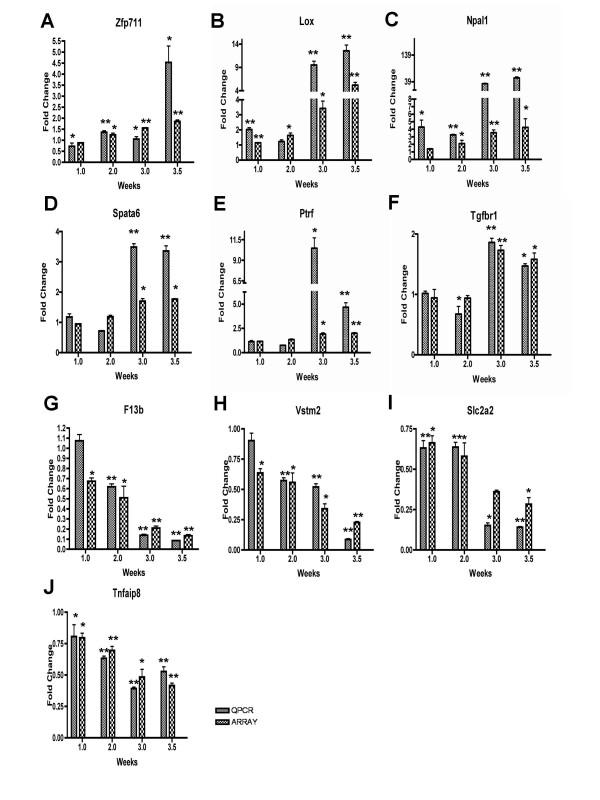
RT-PCR analyses of selected genes (Zfp711, Lox, Npal1, Spata6, Ptrf, Tgfbr1, F13b, Vstm2, Slc2a2 and Tnfaip8) of Pkd1L3/L3 and control mice at different stages. RNA was extracted from Pkd1L3/L3 mice and age-matched control littermates at PNW 1, 2, 3 and 3.5. Three micrograms of total RNA from each group were reverse transcribed and cDNA equivalent to 10 ng total RNA was used for the PCR reactions. The graphs represent the relative change compared to control groups after normalization against Gapdh expression (mean ± SD of triplicate PCR reactions of pooled RNA; n = 3; *, P < 0.05; **, P < 0.01 compared with wild-type mice, by Student's t-test).